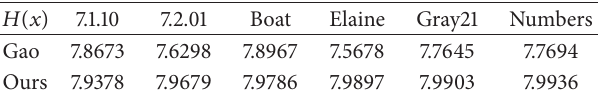
Table 2: Two kinds of algorithm ciphertext image information